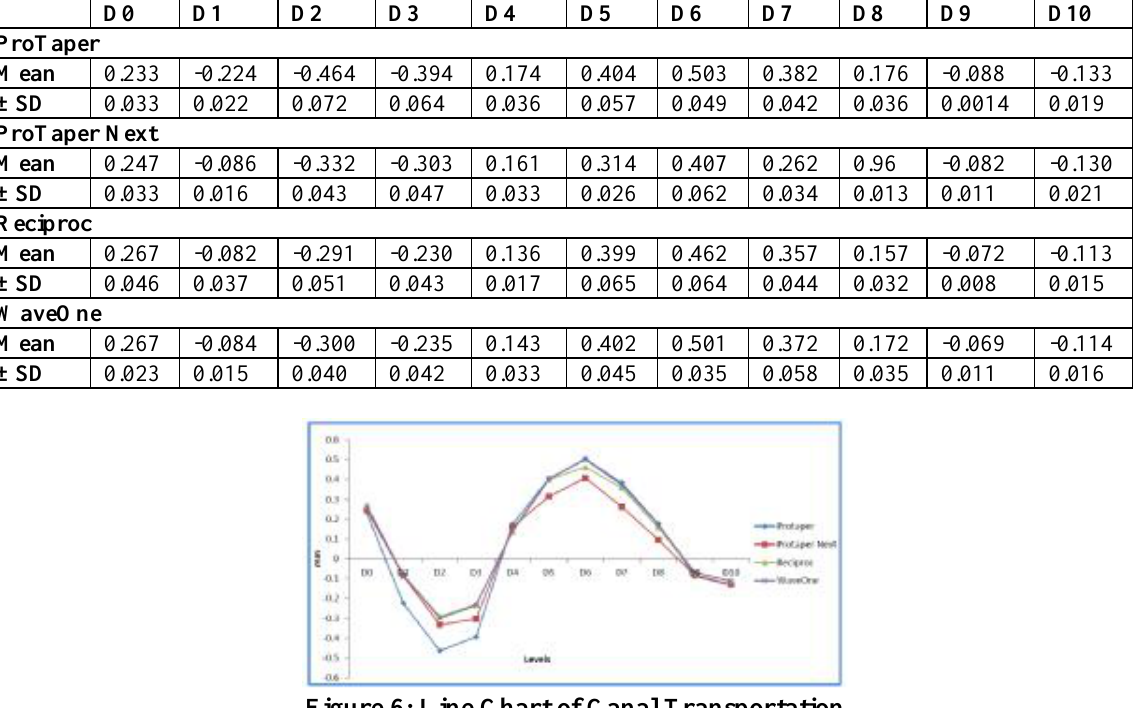
Table 2: Canal Transportation and Standard Deviation at Different Levels of All Groups. (D0 to D10) Measure Points (in mm from the Foramen).